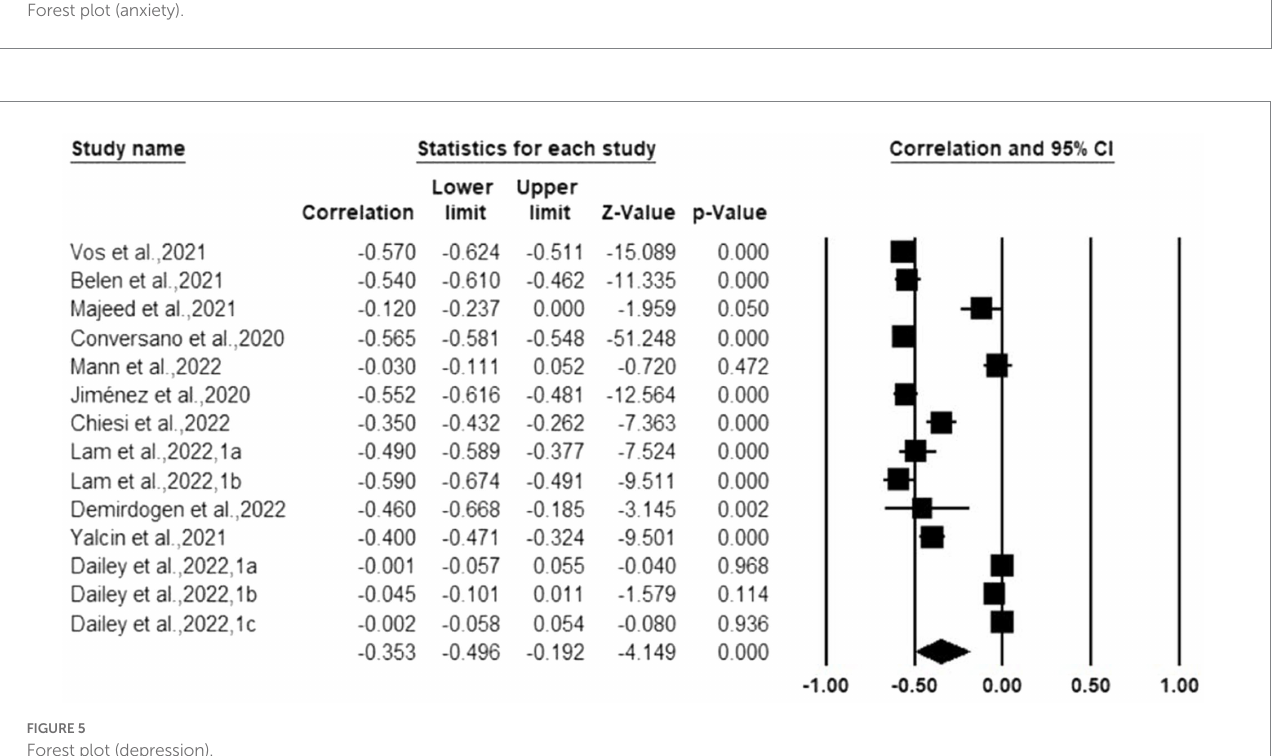
FIGURE 4 Forest plot (anxiety).